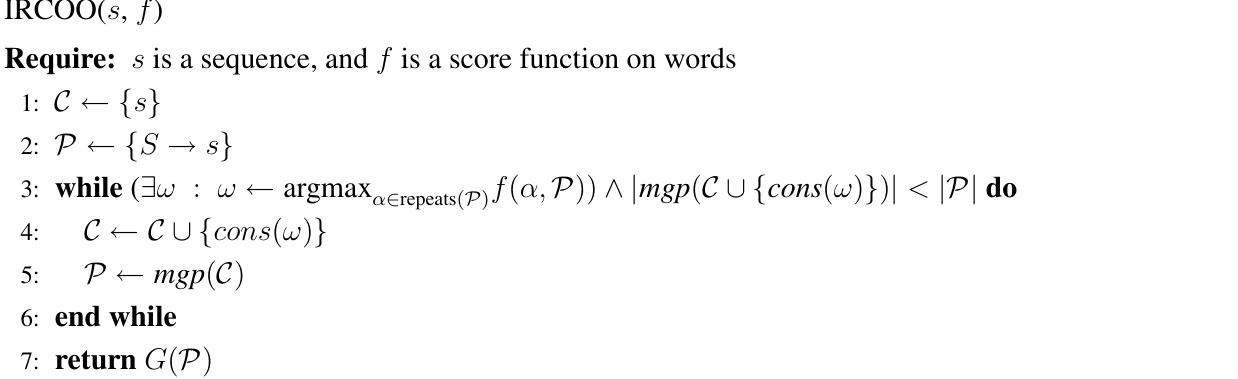
Algorithm 2 Iterative Repeat Choice with Occurrences